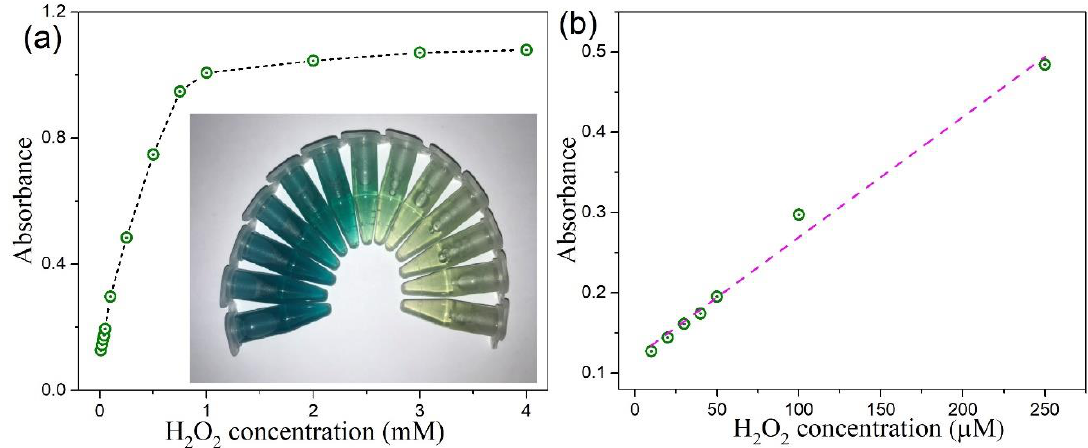
Figure 14. ( a ) The dose-response curve for H 2 O 2 detection by using 2D CTAB-MoSe 2 NSs as artificial enzyme. The inset are the photos of reaction solutions after adding different concentrations of H 2 O 2 . ( b ) The linear calibration plot for H 2 O 2 concentration. Table 1. Comparison of colorimetric detections of H 2 O 2 in the linear range and detection limit between our MoSe 2 nanostructures and other peroxidase mimics based on nanoscale 2D materials. Catalyst Linear Range ( µ M) Detection Limit ( µ M) Ref. Positively-charged Au nanoparticles (NPs)h-BN / N-MoS 2 Few-layered MoSe 2 nanosheets